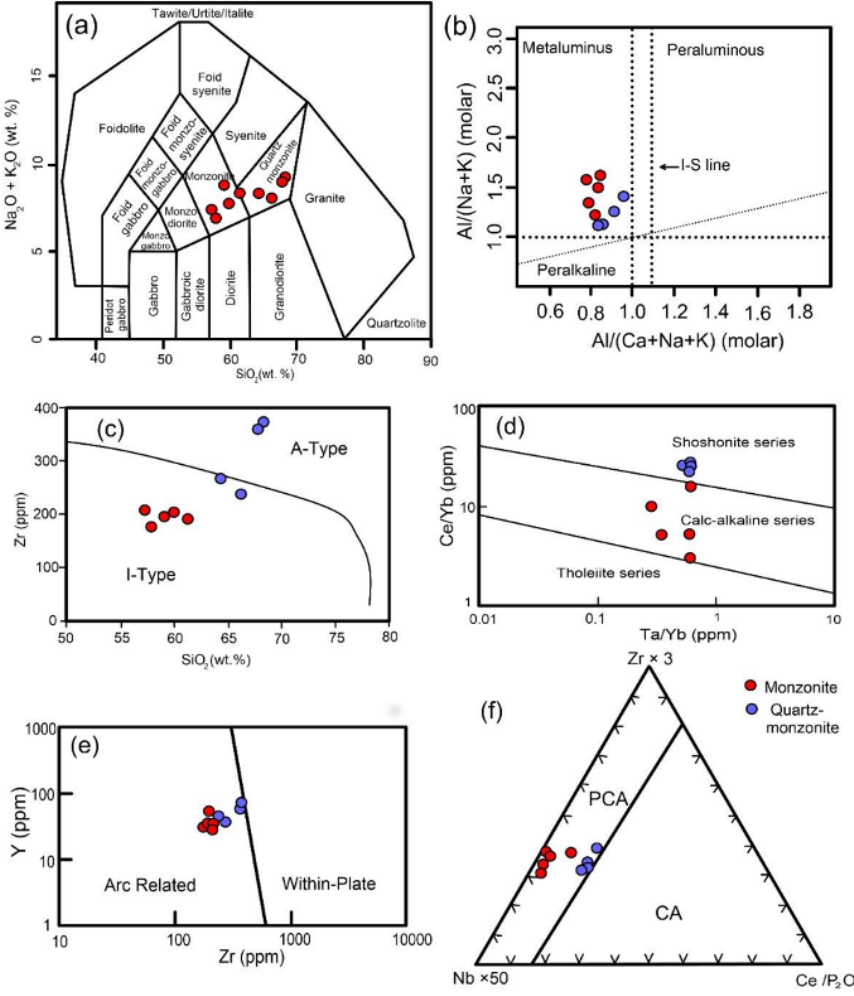
Figure 7. Geochemical variation diagrams for the Shah-Ali-Beiglou stock. ( a ) Rock classification diagram [57] for the Shah-Ali-Beiglou stock; ( b ) Al/Na + K (molar) versus Al/Ca + Na + K that showing all of the samples exhibit metaluminous geochemical characters (after Maniar and Piccoli [58]) diagram; ( c ) Zr versus SiO 2 diagram proposed by Collins et al. [59] that showing most of the samples have I-type geochemical characters; ( d ) Ce/Yb versus Ta/Yb diagram for the samples with lines separating the tholeiitic, calc-alkaline, and shoshonitic series [60] that showing samples have calc-alkaline to shoshonitic affinity; ( e ) Y versus Zr diagram [51] that showing samples plot within the arc related field; ( f ) Zr × 3-Nb × 50-Ce/P 2 O 5 tectonic setting discrimination diagram [51] that showing samples plot within the post-collisional arc field